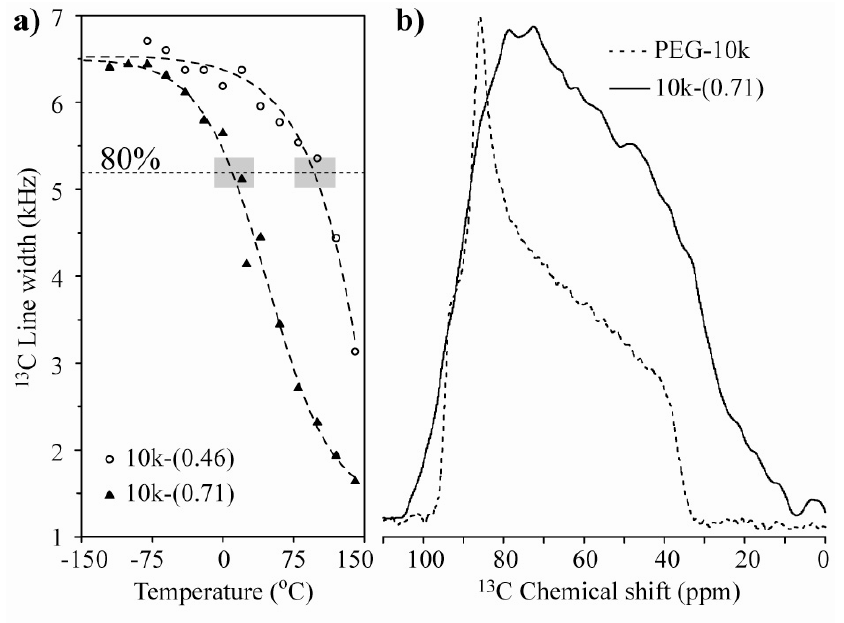
Figure 3. ( a ) 13 C line-width versus temperature for the 10k-(0.46) and 10k-(0.71) samples. The horizontal dashed line and the gray boxes represent the regions where the line-widths correspond to approximately 80% of their rigid limit values; ( b ) Room temperature 13 C = 10,000 g/mol and the 10k-(0.71) NMR spectra for pure PEG with M w